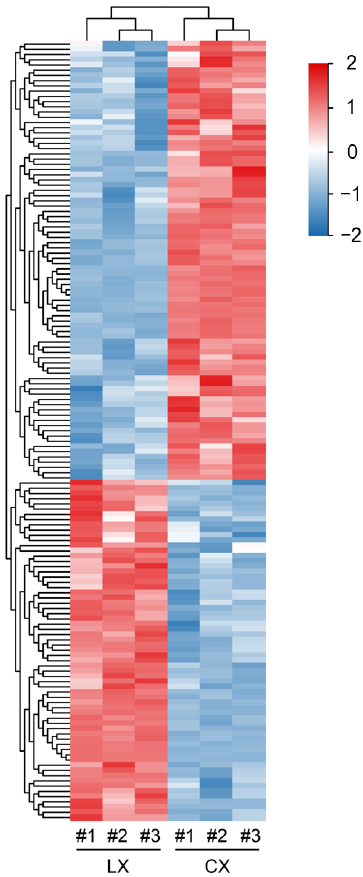
Figure 4. Identification of differentially abundant metabolites (DAMs). ( A ) Volcano plots of DAMs between CX and LX. ( B ) Top 20 most significant DAMs.